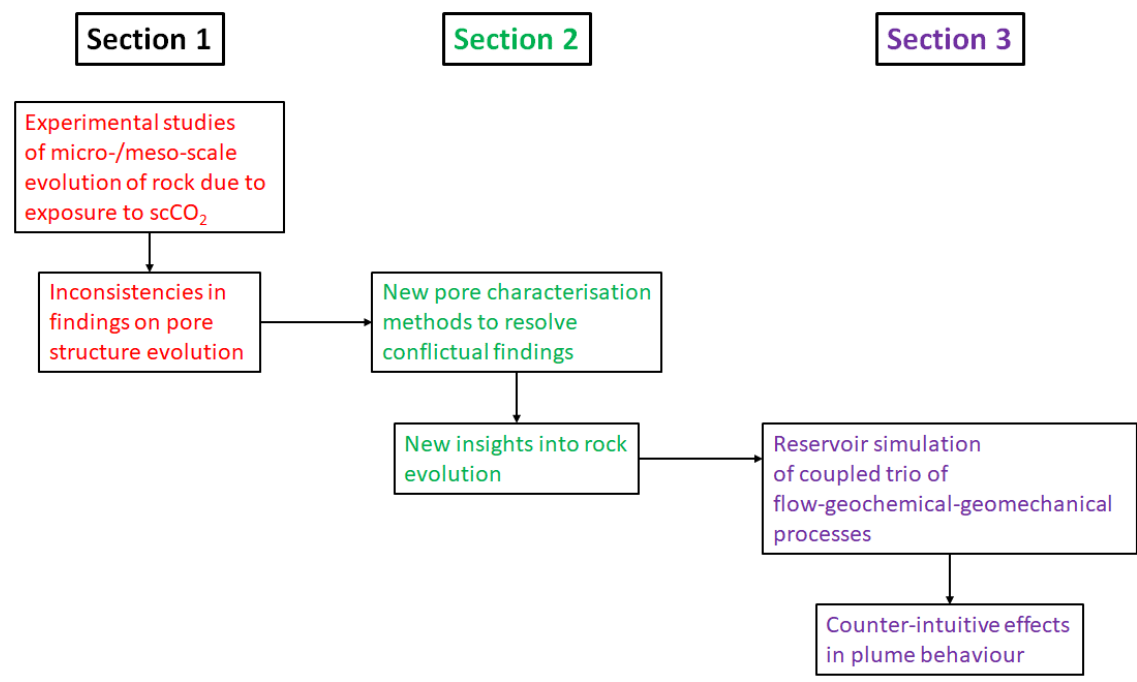
Figure 1. Schematic diagram showing the structure of this review.